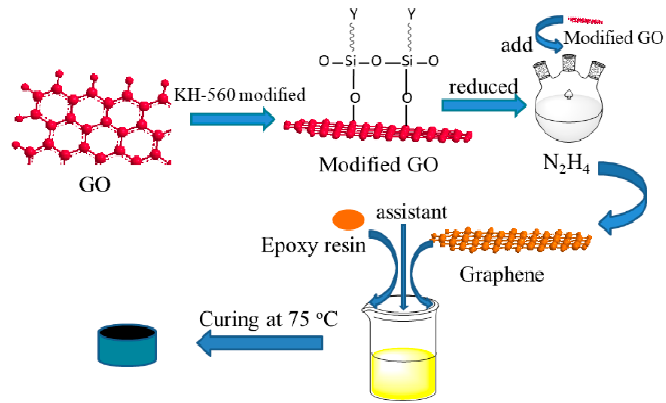
Figure 6. Illustration diagram of the preparation process of the modified GE/EP composite via a double injection method.